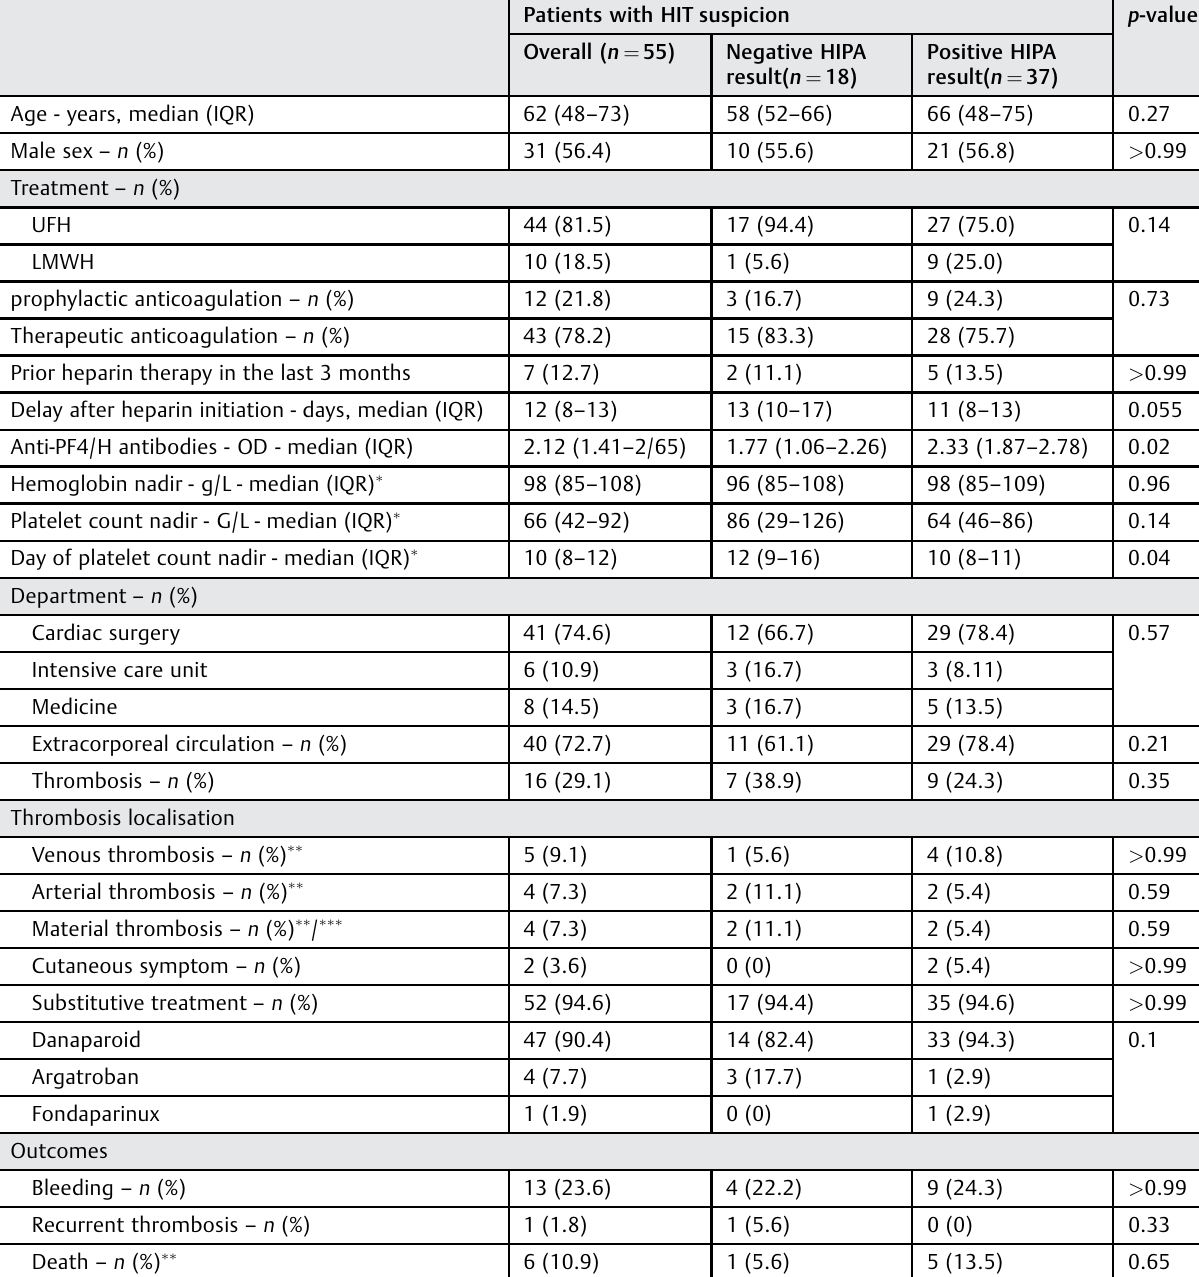
Table 1 Demographic, clinical and biological characteristics of patients with heparin-induced thrombocytopenia suspicion Patients with HIT suspicion